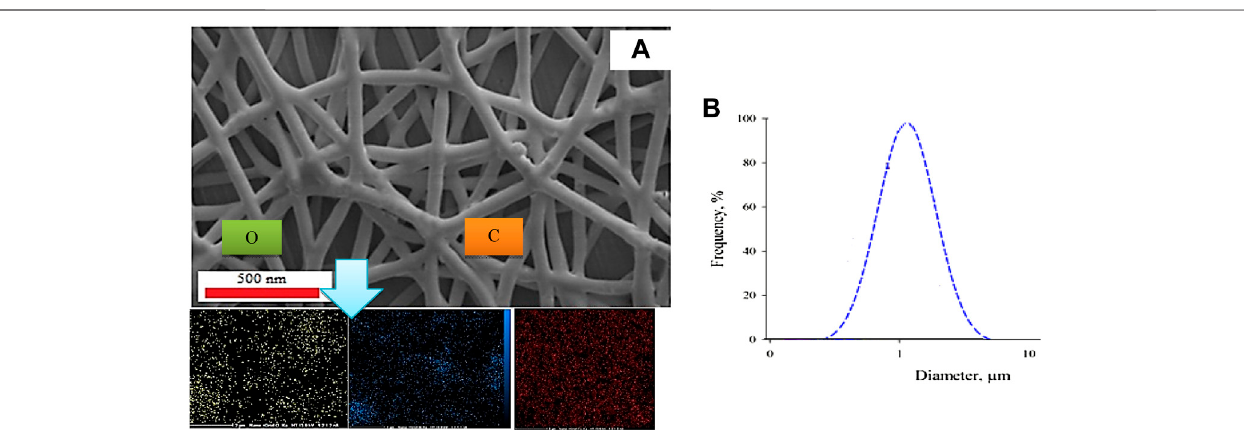
FIGURE 4 | image of (A) fi brous nanostructures based on cyclodextrin and (B) egg shell powder.